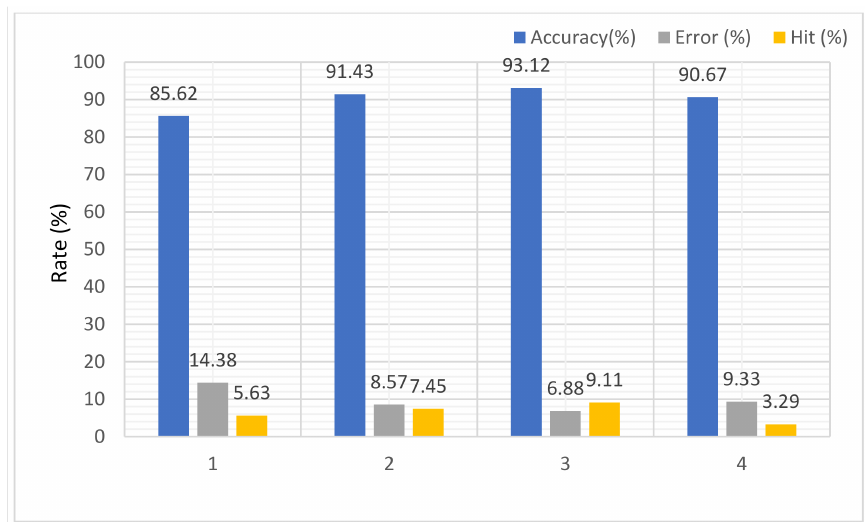
Figure 12. Performance report for Utube video images.